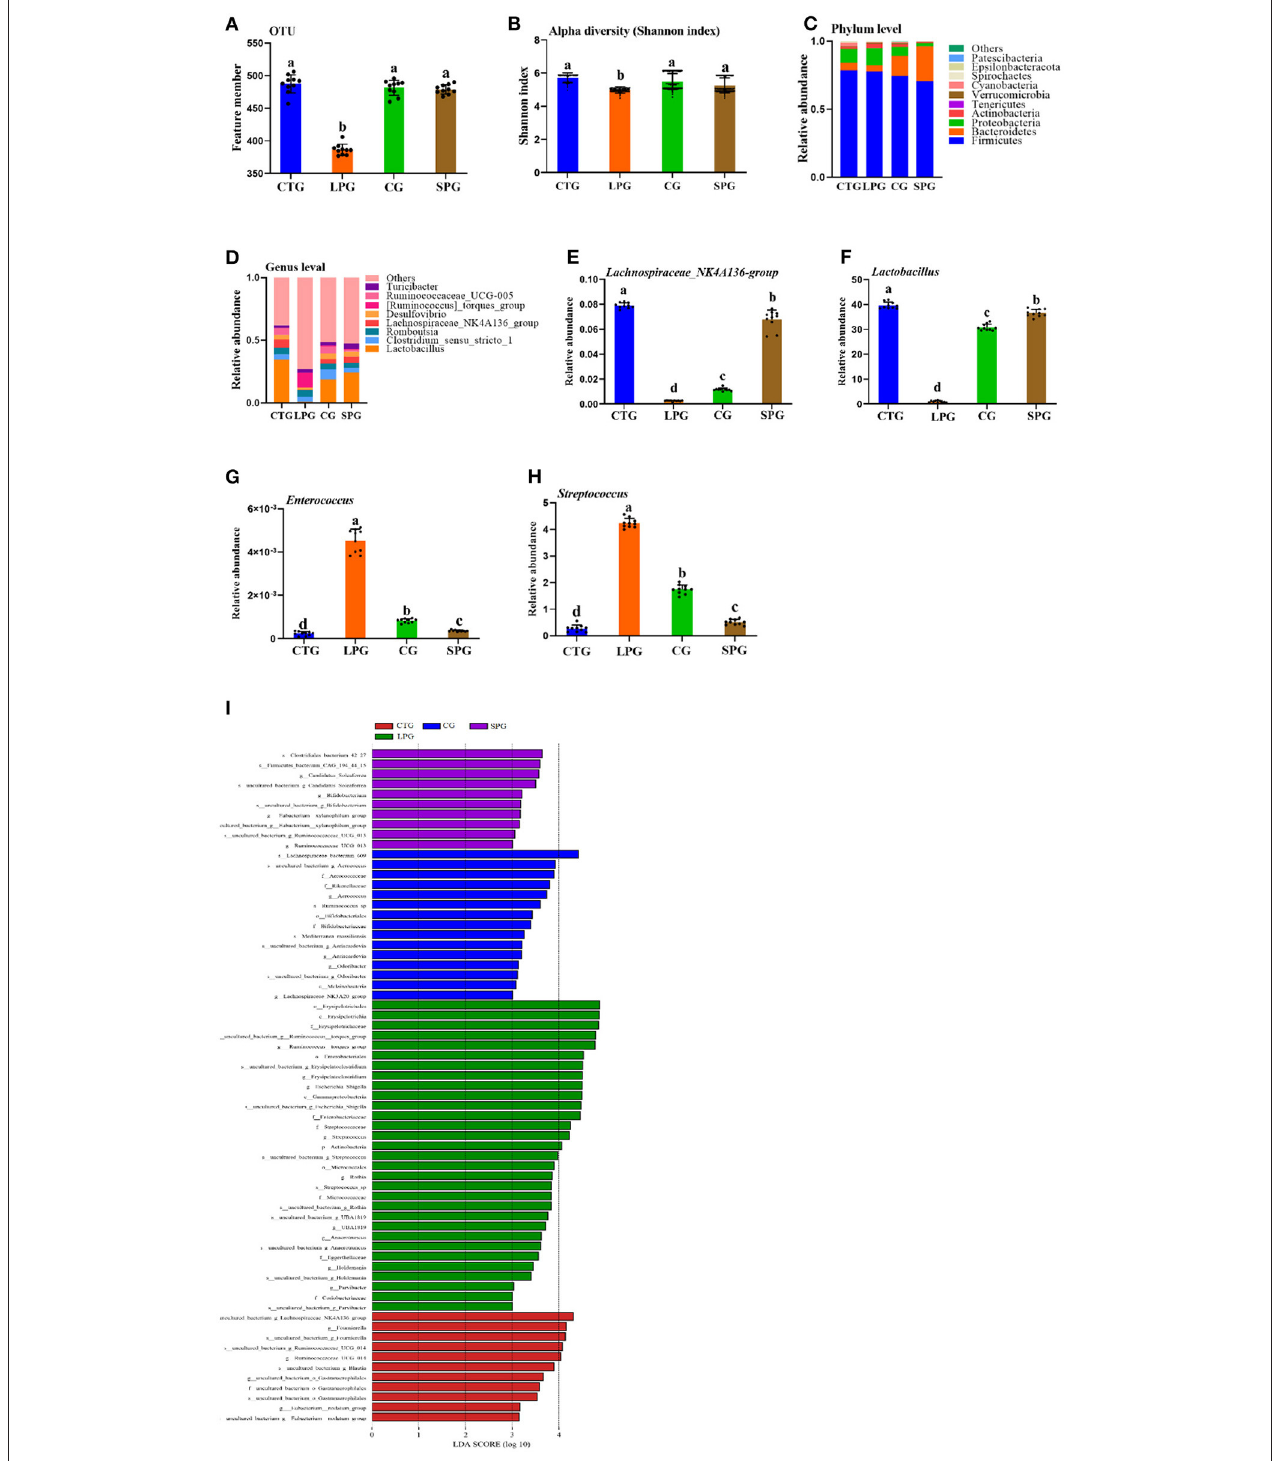
FIGURE 4 | Effect of diet intervention on the gut microbiota. (A) The amount of OTU based on 97.0% similarity. (B) Shannon index. (C) The change in the phylum level. (D) The change in the genus level. (E) The relative abundance of Lachnospiraceae_NK4A136- group . (F) The relative abundance of Lactobacillus . (G) The relative abundance of Enterococcus . (H) The relative abundance of Streptococcus . (I) LDA score of four diets on microbiota. Data are presented as mean ± SEM. Different letters indicate statistical differences among the groups ( p < 0.05). OTU, operational taxonomic unit; CTG, control group; LPG, low protein group; CG, casein group; SPG, soy protein